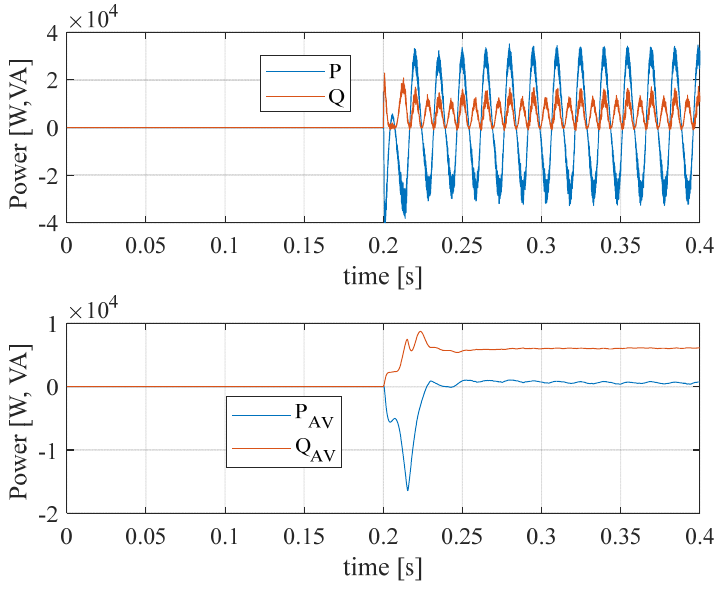
Figure 15. Active and reactive power during compensation of ICE engine torque oscillations.